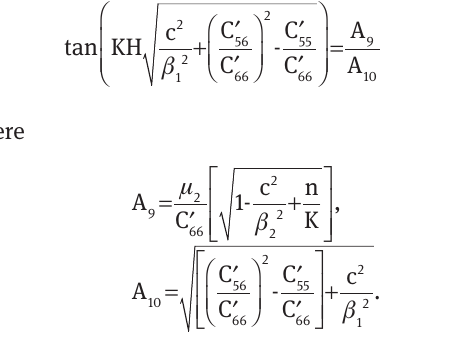
Here, Eq. (36) represents the dispersion relation for the propagation of SH waves in a homogeneous mono- clinic layer lying over an isotropic non-homogeneous semi-infinite